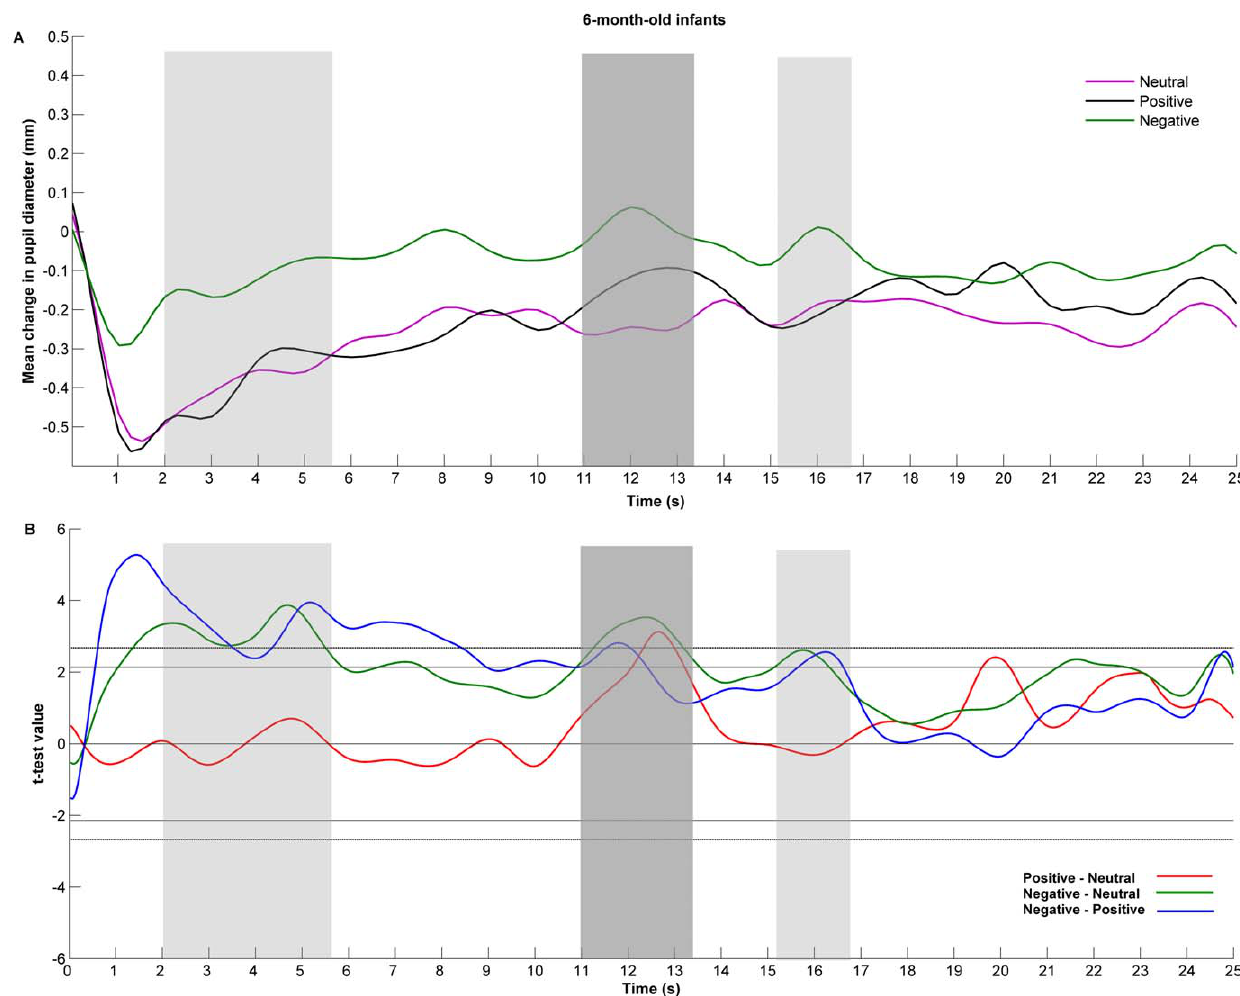
Figure 4. Six-month-old infants ’ pupil size changes in response to others ’ affective displays. In Panel A, functional expression of changes in the 6-month-olds baseline corrected pupil size in response to others’ neutral (purple line), positive (black line), and negative (green line) emotional displays. Panel B shows the value of t statistic as a function of time for each pair of stimuli comparison: positive vs. neutral (red line), negative vs. neutral (green line), and negative vs. positive (blue line). The one-tailed critical values of t are represented by the vertical lines with (dotted) and without (solid) Bonferroni correction for three comparisons. The difference is considered to be significant when this line is reached or surpassed. Marked with dark gray are those time windows in which both emotional conditions triggered larger pupil diameters than the neutral one, and the hypothesized negativity bias occurred. Marked with light gray are those time windows where negative emotions triggered larger pupil diameter compared to the emotionally neutral state. (Note that the shaded areas are for illustrative purposes only, marking the time window in which the effect occurred and not the effect duration.)